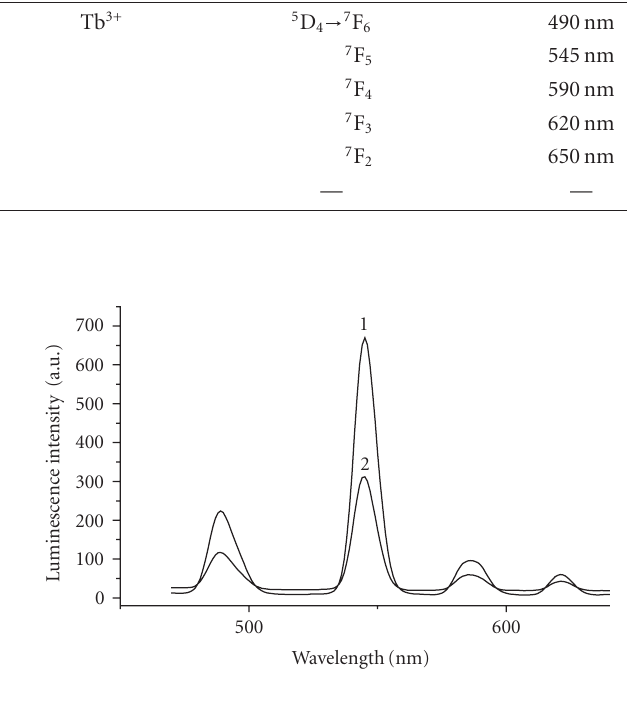
Figure 5: Luminescence emission spectra of 3 10 (cid:0) 4 M of Tb 3+ in (cid:0) 10 (cid:0) 5 M of (I) and (2) 8 10 (cid:0) 5 M of (II) in the presence of (1) 8 (cid:0) (cid:0) [PMMA = 4gm/25ml at λ ex =